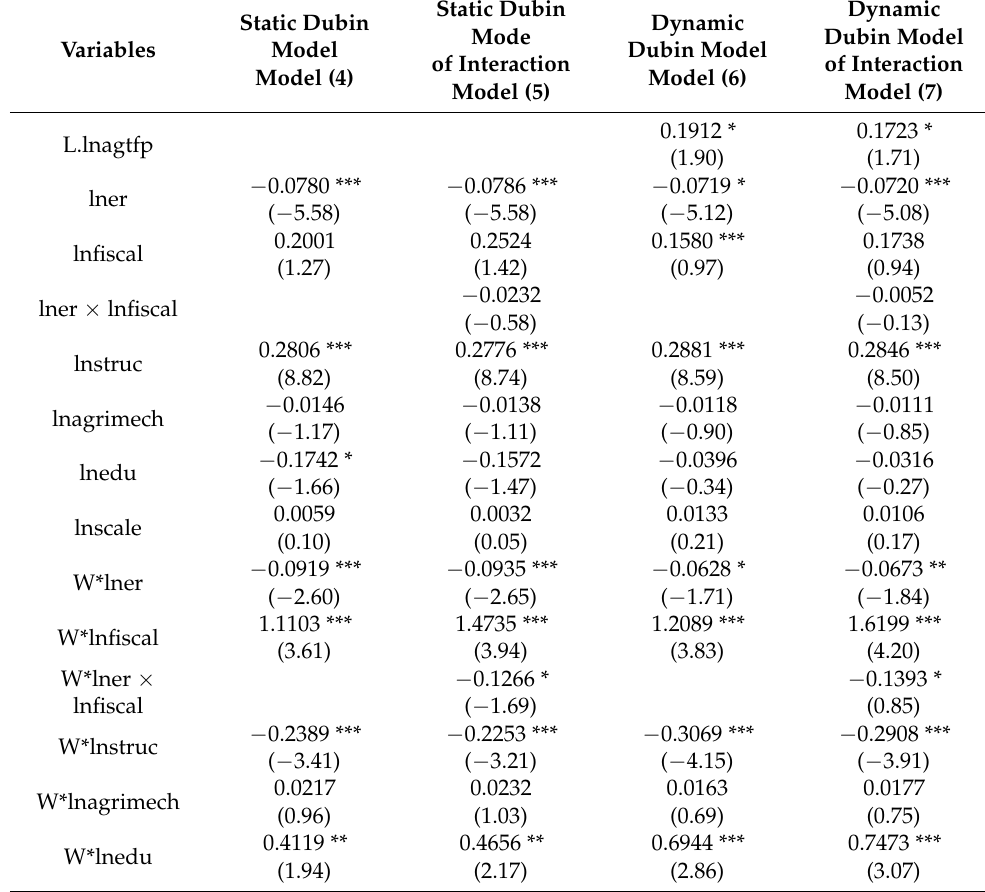
Table 4. The results of spatial Dubin model